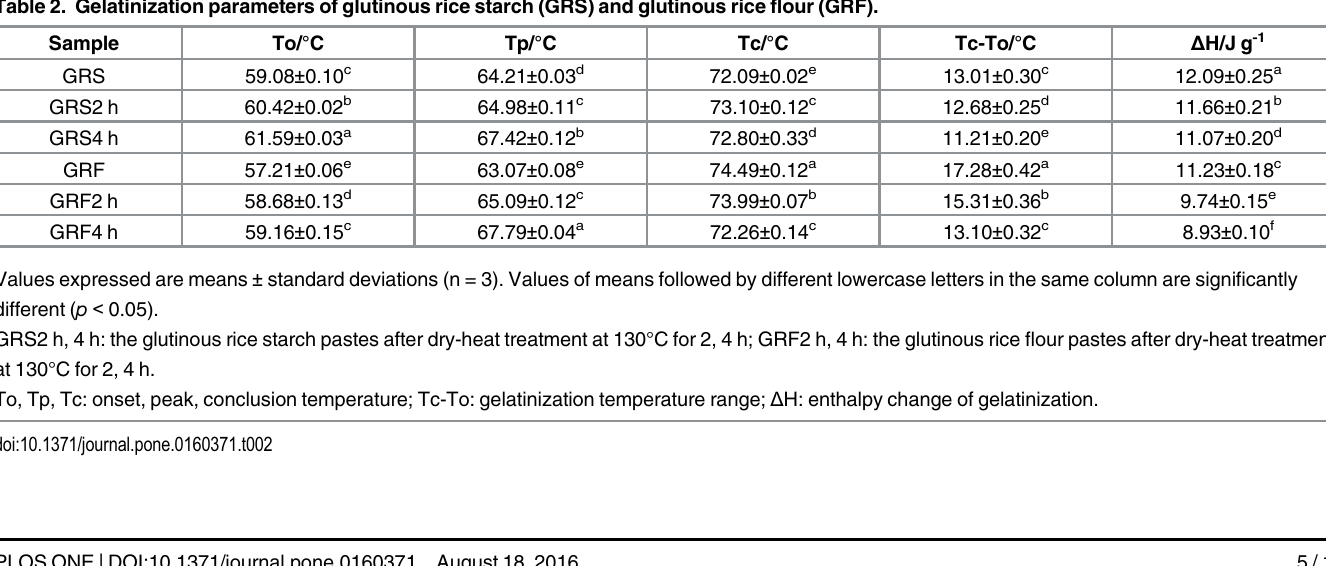
Table 2. Gelatinization parameters of glutinous rice starch (GRS) and glutinous rice flour (GRF). Sample